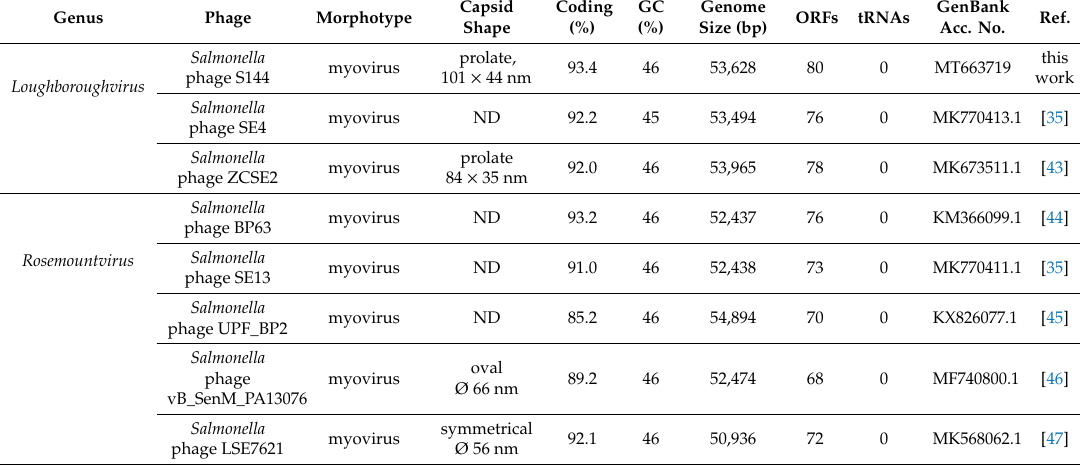
Table 3. Morphological (morphotype, capsid shape) and genomic features (percentage of coding genome, GC content, genome size, ORFs, tRNAs synthesis genes) of S144, its two closest relatives belonging to the Loughboroughvirus genus and five representative phages from the Rosemountvirus genus. The GenBank accession number and the reference are also reported. ND: not